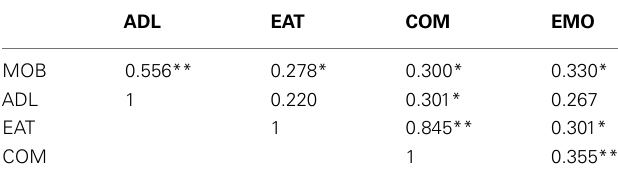
Table 6 | Correlation between areas at the third